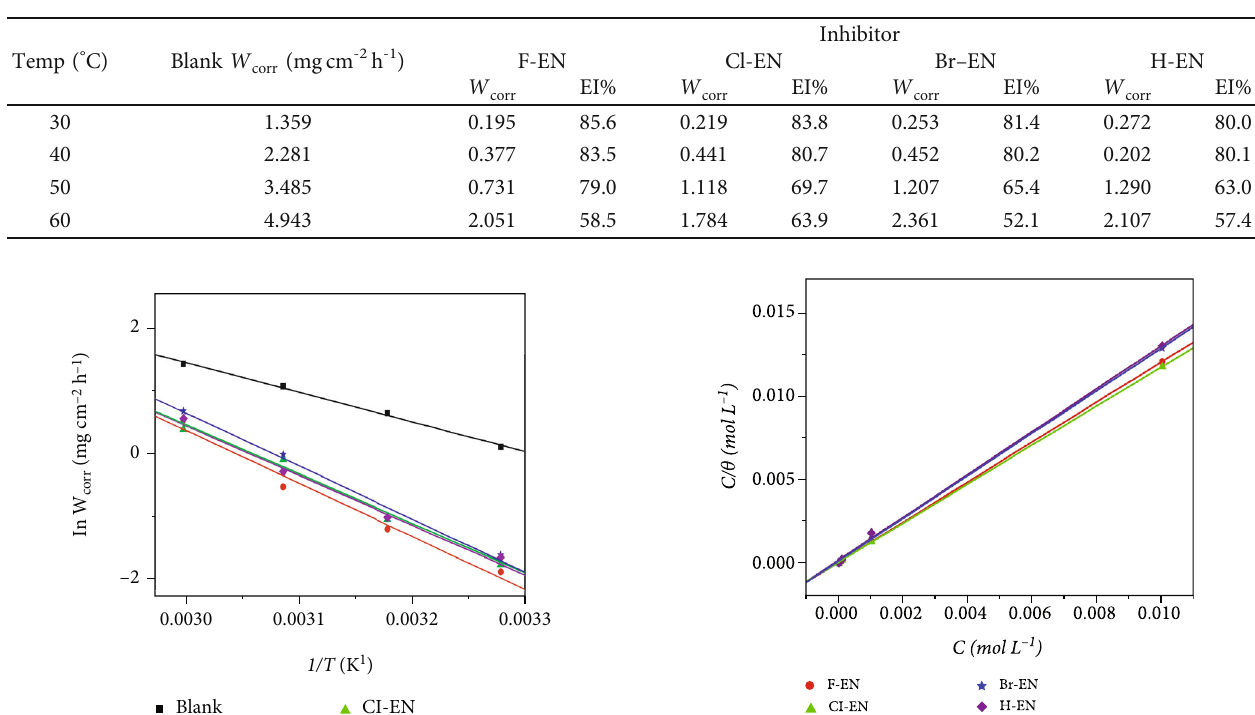
Table 6: Weight loss data for carbon steel AISI 1020 in 1.0molL -1 HCl solution in the absence and presence of inhibitors at 3 h of immersion time with variable temperature.